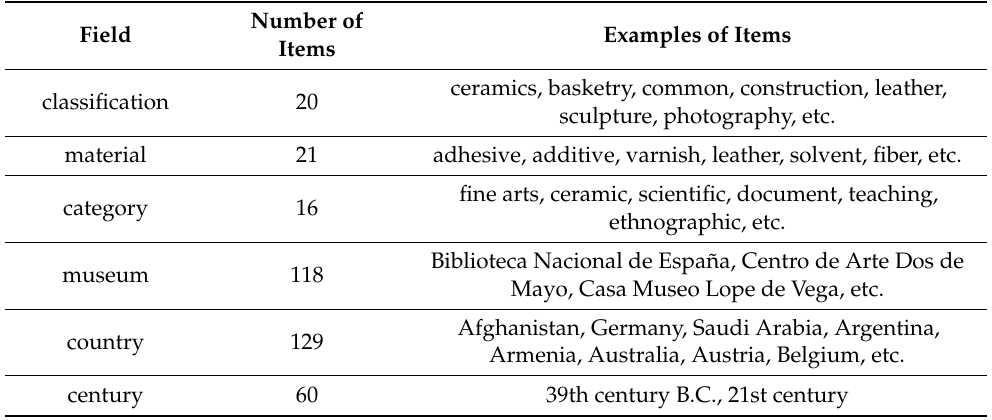
Table 1. Summary of the filters according to the field and items. Note that some terms have been translated into English in the current paper for the sake of clarity.